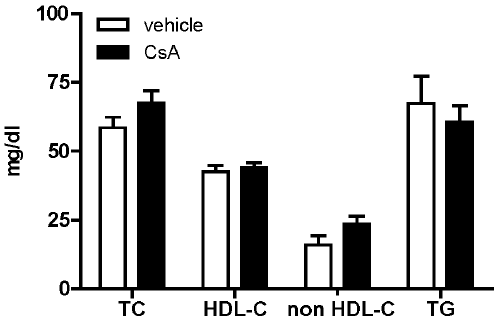
Figure 1. CsA treatment effect on plasma lipid levels in mice. C57BL/6 mice were treated with CsA 50 mg/kg/d (black bar) or vehicle (white bar) for 14 days. Total cholesterol (TC), HDL-cholesterol (HDL-C) and triglycerides (TG) were measured by an enzymatic assay. Non HDL- cholesterol (non HDL-C) is calculated as the difference between TC and HDL-C. Data are expressed as mean 6 SD (values are mean of 7 animals).